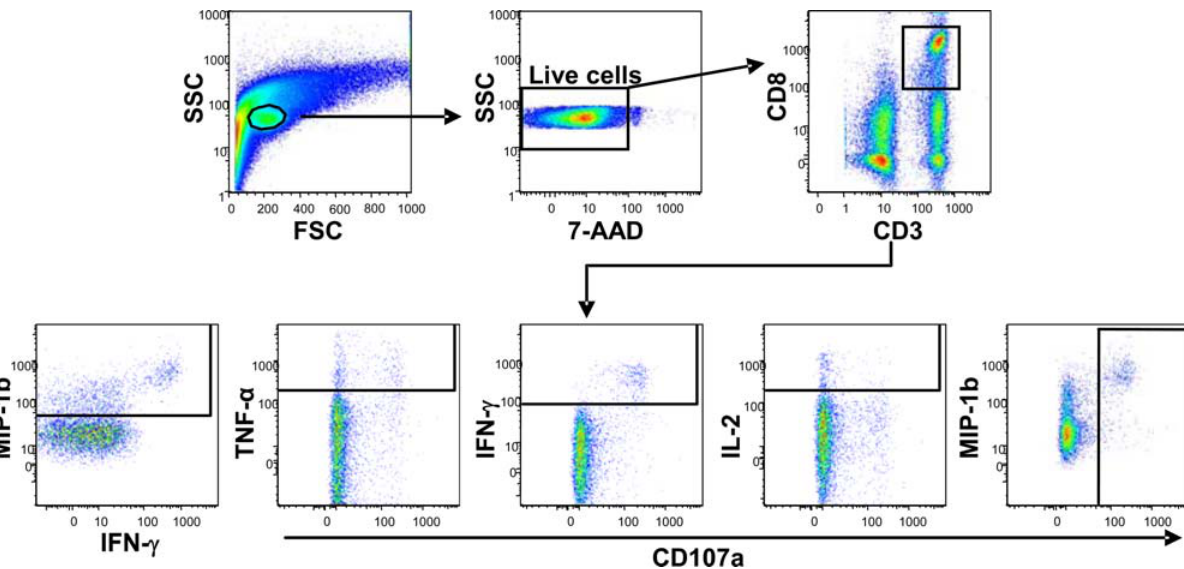
Figure 1. Flow cytometry gating method used in the analysis of CD8 + T-cell responses. Shown is a typical rectal mucosal cell preparation that was stimulated with HIVgag peptides. After initial estimation of a lymphocyte gate based on forward versus side scatter, viable cells (7-AAD negative) were carried forward for selection of CD3 + CD8 + cells. The resulting CD3 + CD8 + population was further gated based on positivity for each of the 5 functional responses measured: MIP-1 b , TNF- a , IFN- c , IL-2 and CD107a. The frequencies of cells in these populations were corrected using background values (costimulation only) and then compiled and analyzed directly. For more detailed analyses, the 5 populations were instead entered into Boolean gating analysis to generate 31 populations consisting of all possible combinations of functionality (the 32 nd population representing cells negative for all 5 functions was ignored). Background correction was applied after Boolean gating (see Methods).